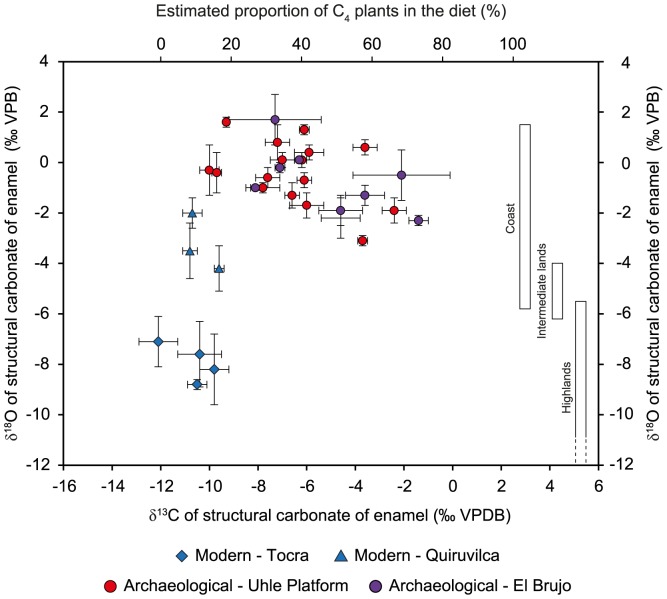
Mean isotopic composition of enamel structural carbonate.Plot of mean δ13C and δ18O values (‰ VPDB) of enamel structural carbonate for all teeth (molars) of archaeological and modern highland domestic camelids. The proportion of C4 in the diet was reconstructed using estimated mean pre-industrial δ13C values of pure-C3 and pure-C4 feeders. Estimated ranges of δ18O values for animals raised in the three ecozones are represented by rectangles.